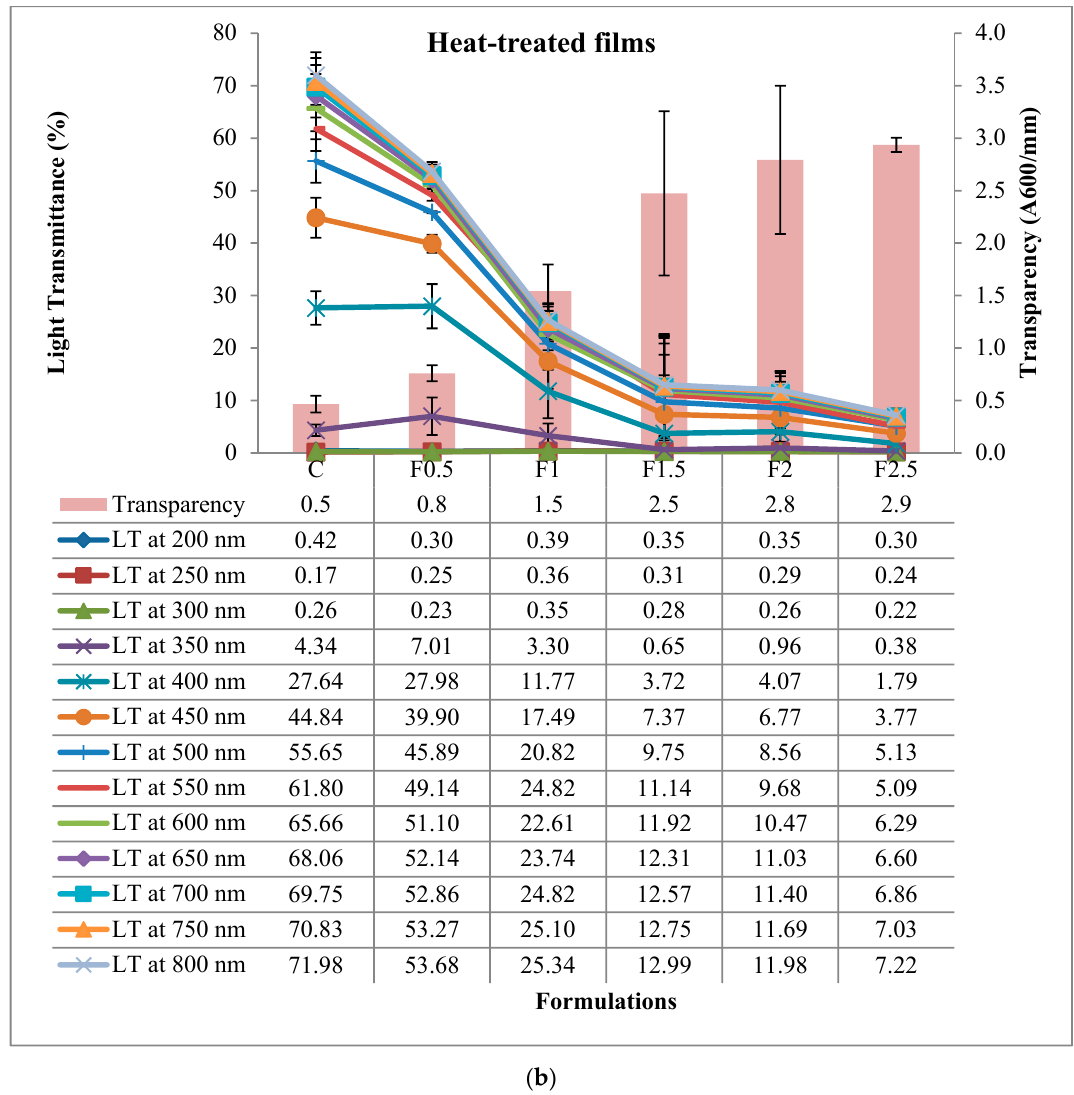
Figure 8. Light transmittance and transparency of edible films. ( a ) Untreated, ( b ) heat-treated. C-control film; F0.5-film with 0.5% tarragon essential oil; F1-film with 1% tarragon essential oil; F1.5-film with 1.5% tarragon essential oil; F2-film with 2% tarragon essential oil; F2.5-film with 2.5% tarragon essential oil. Values are expressed as mean ± standard deviation of three replicates for light transmittance and transparency.